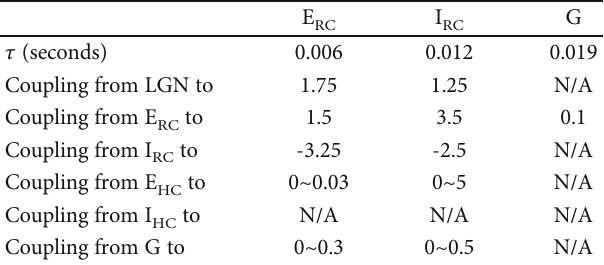
Table 1: Parametersinthemodel.Row1showsthetimeconstants τ s. Rows 2-7 illustrates the values of coupling strength in the